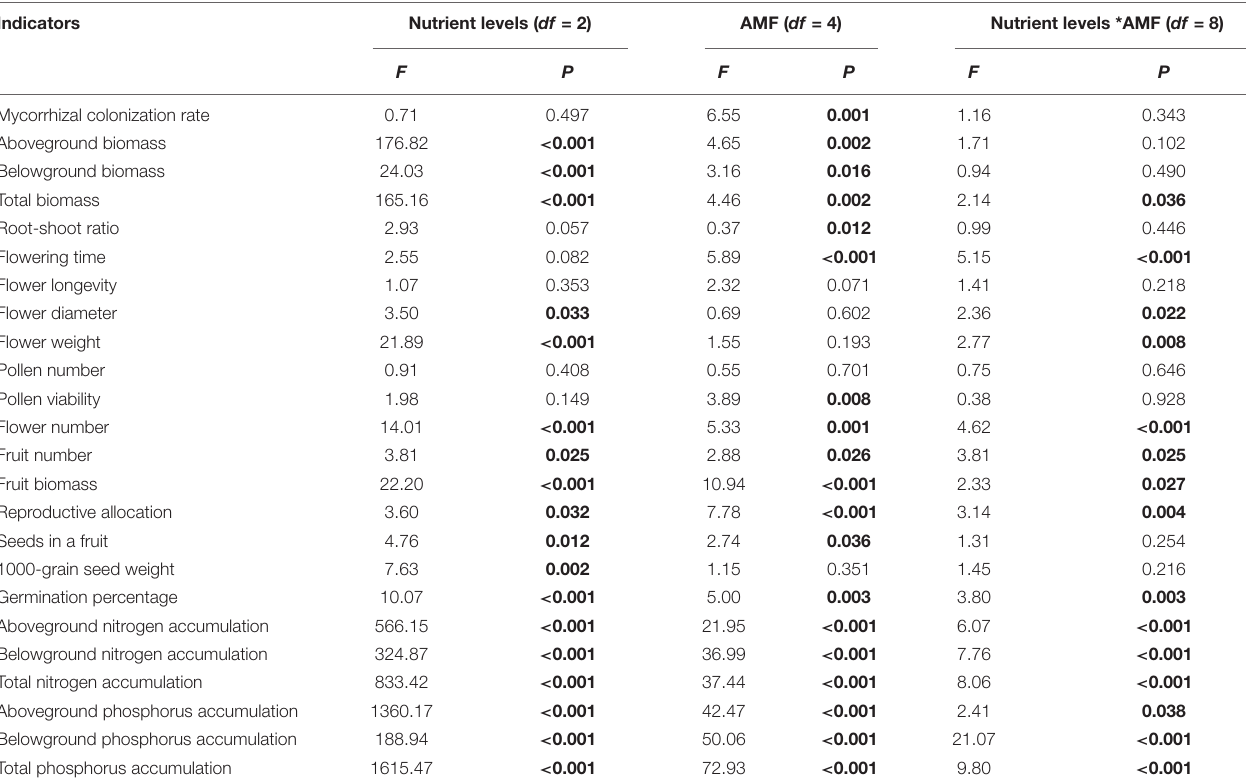
TABLE 2 | Effects of nutrient levels, AMF inoculation treatments and their interaction on root infection rate, growth and reproductive traits of cherry